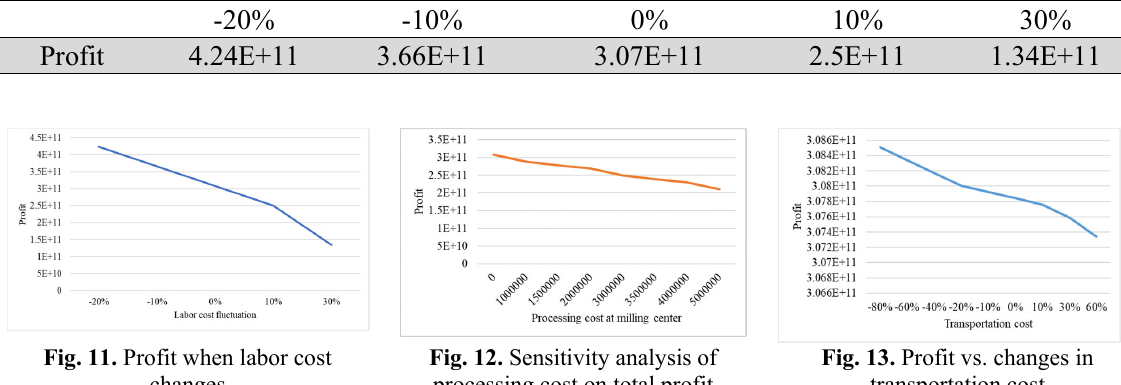
Fig. 12. Sensitivity analysis of processing cost on total profit